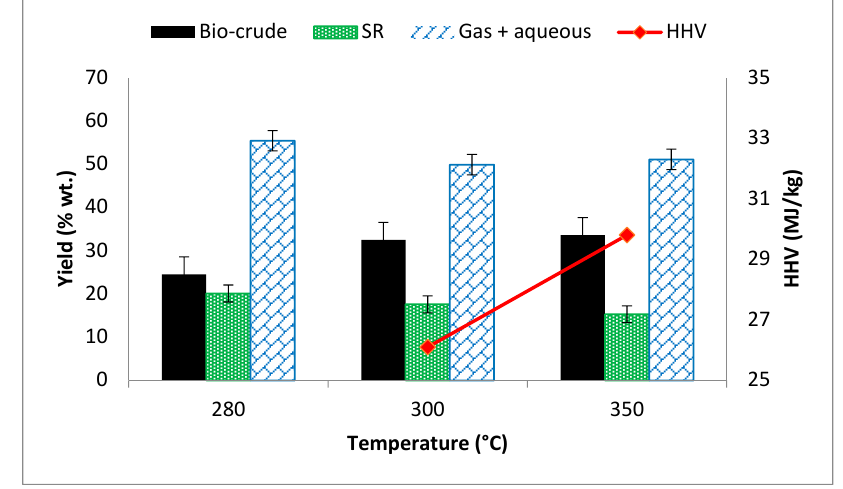
Figure 3. Influence of the reaction temperature on products yields at 25% solids concentration and 60 min reaction time in nitrogen atmosphere (2 bar at commencement). Values are for yield data.